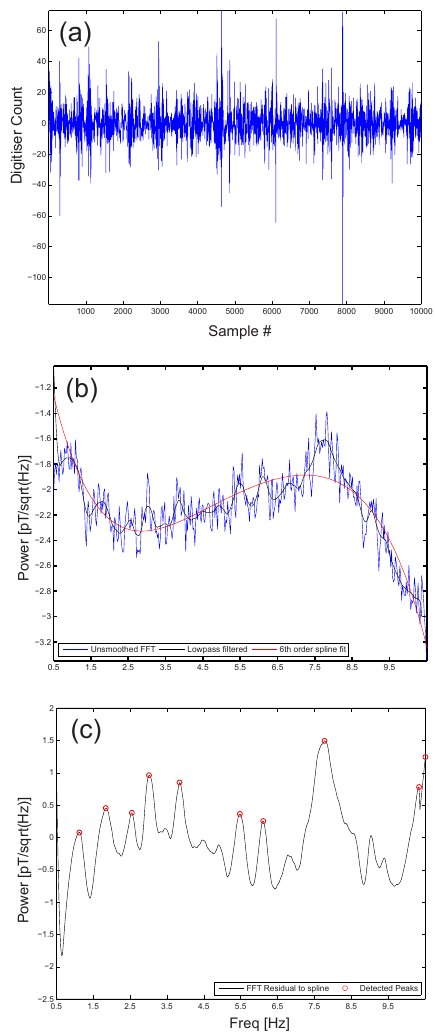
Figure 2. Signal processing protocol for identifying SRS peaks for 14–15 February 2014. See text for details. (a) De-trending and fil- tering of 100s of 100Hz raw digitiser data. (b) FFT of 100s of Hanning-windowed data (blue), 14-point running average smoothed FFT data (red) and sixth-order spline background (black); (c) spline background removed from smoothed FFT with main peaks identi- fied